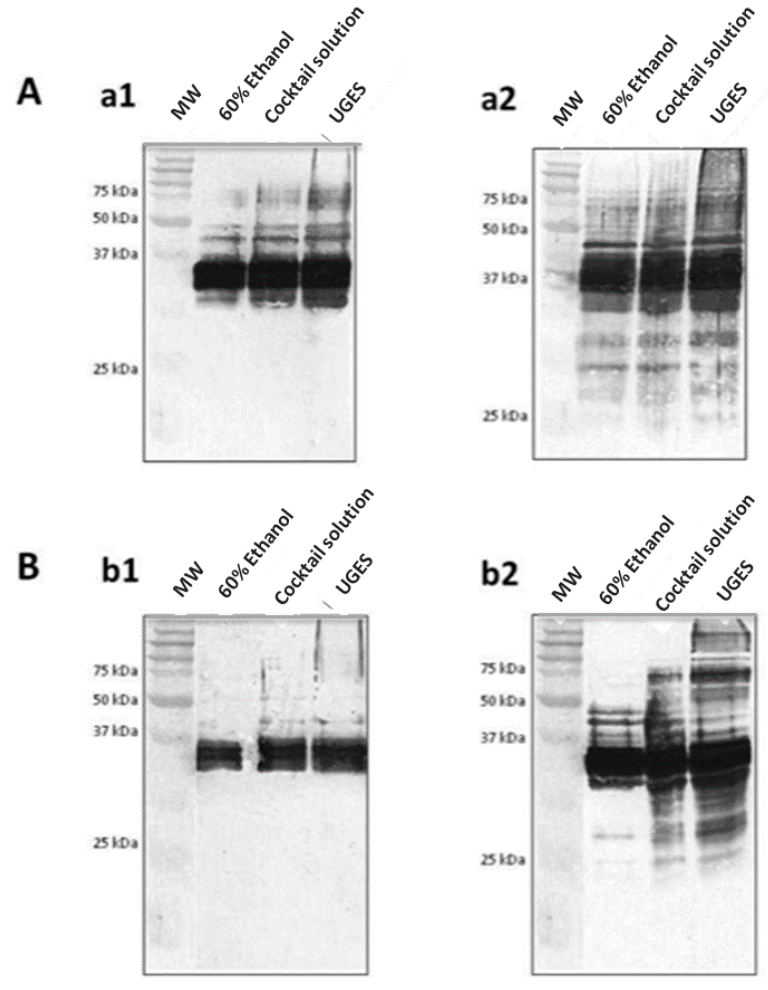
Figure 5. Western blot analysis of gluten using different extraction procedures. ( A ) The efficiency in the extractability of Prolamin Working Group (PWG) gliadins with ( a1 ) G12 monoclonal antibody (moAb) and ( a2 ) A1 moAb. ( B ) The efficiency in the extractability of gluten from two commercial samples: ( b1 ) biscuits and ( b2 ) wheat flour ( Triticum durum ). MW, molecular weight marker.